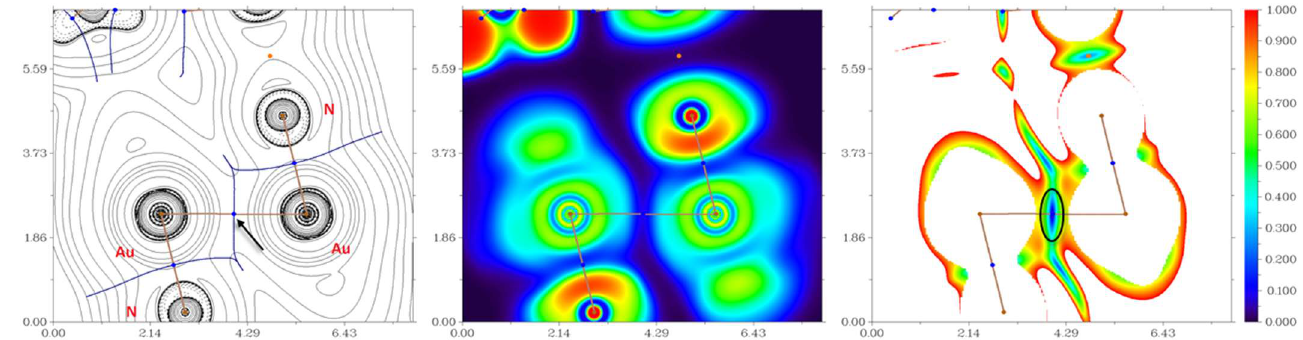
Table 1. The density of all electrons, ρ( r ); Laplacian of electron density,  2 ρ( r ); appropriate λ 2 eigen- value; energy density, H b ; potential energy density, V( r ); and Lagrangian kinetic energy, G( r ) (a.u.) at the bond critical point (3, –1) corresponding to aurophilic interactions Au(I)···Au(I) in the X-ray structure of 4 .